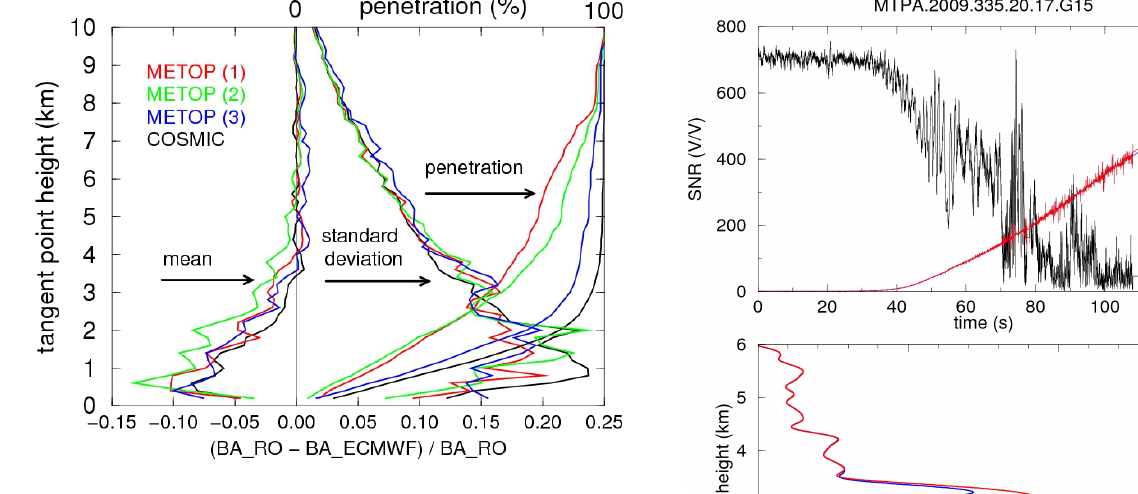
Fig. 22. Statistical comparison of Metop/GRAS and F3C with ECMWF bending angles. Different colors show different Metop/GRAS processing modes (for details see text).